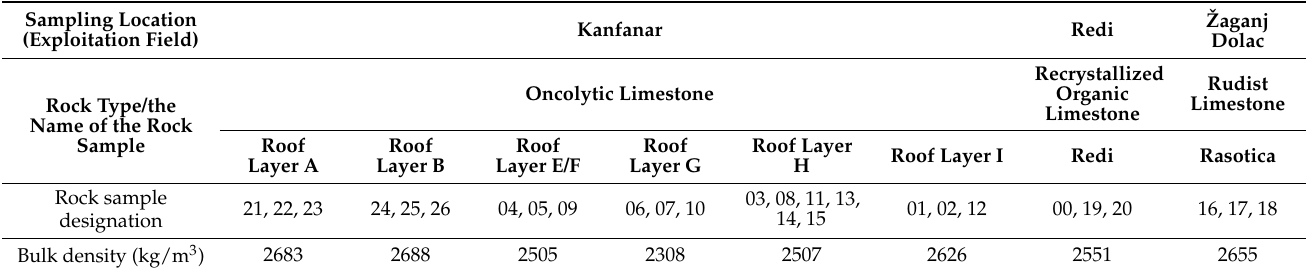
Table 2. Characteristics of rock